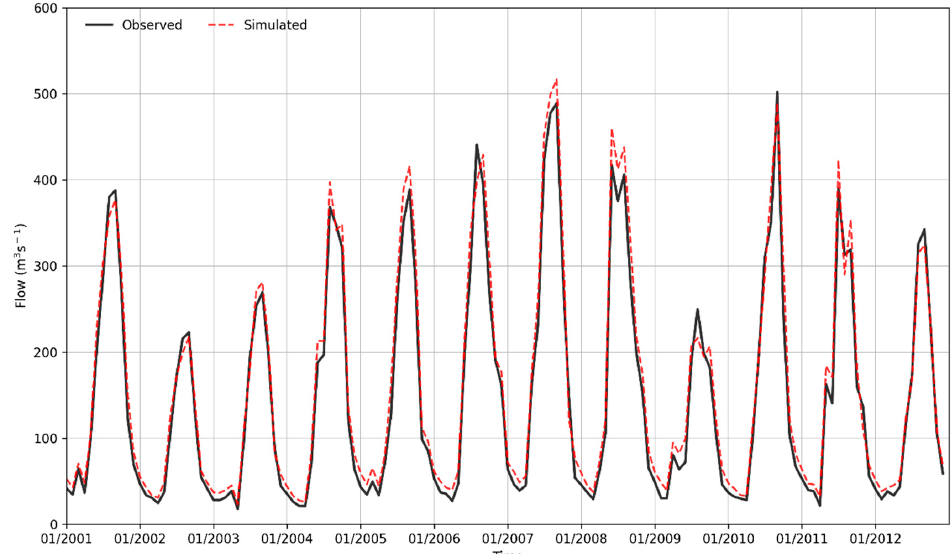
Figure 9. Monthly observed and simulated streamflow for the Validation period (2001–2012).